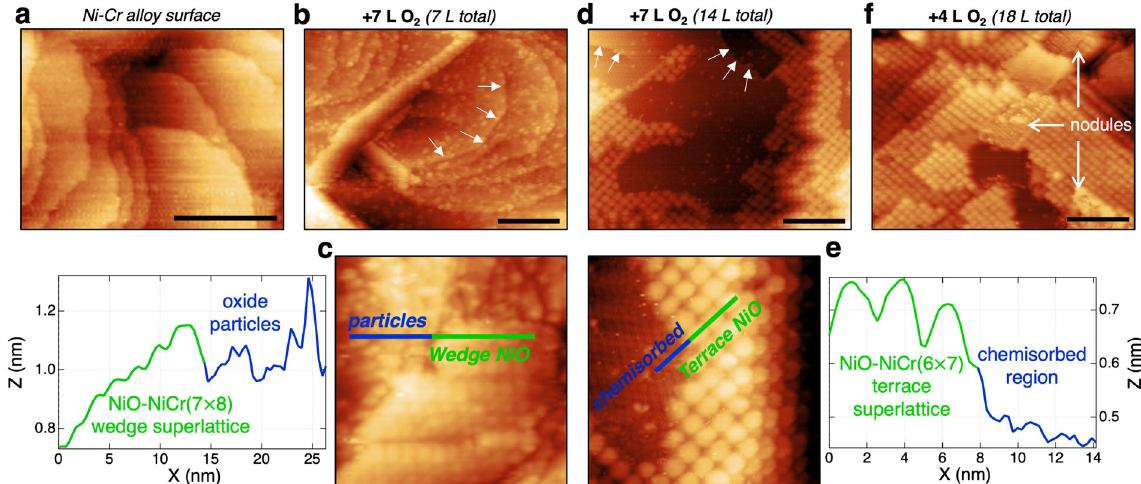
Fig. 1 An overview of the oxidation steps and features on the surface. Topography of the alloy surface prior to oxidation is given in ( a ). The progression of oxidation after cumulative O 2 exposures at 500 °C of 7 L ( b ), ( c ), 14 L ( d ), ( e ), and 18 L ( f ). All scale bars are 20 nm. The white arrows indicate step edges that have not faceted and are still curved despite oxygen exposure. Image ( a ) was measured at V bias = 0.25 V, I t = 0.5 nA, ( b ), ( c ), ( d ) and ( e ) at V bias = 2.0 V, I t = 0.1 nA, and ( f ) at V bias = 3.0 V, I t = 0.1 nA. The images in panels ( c ) and ( e ) are both 30 × 30 nm 2 and show the different features after cumulative 7 L and 14 L exposures, respectively. Line scans of each feature at these oxidation steps are